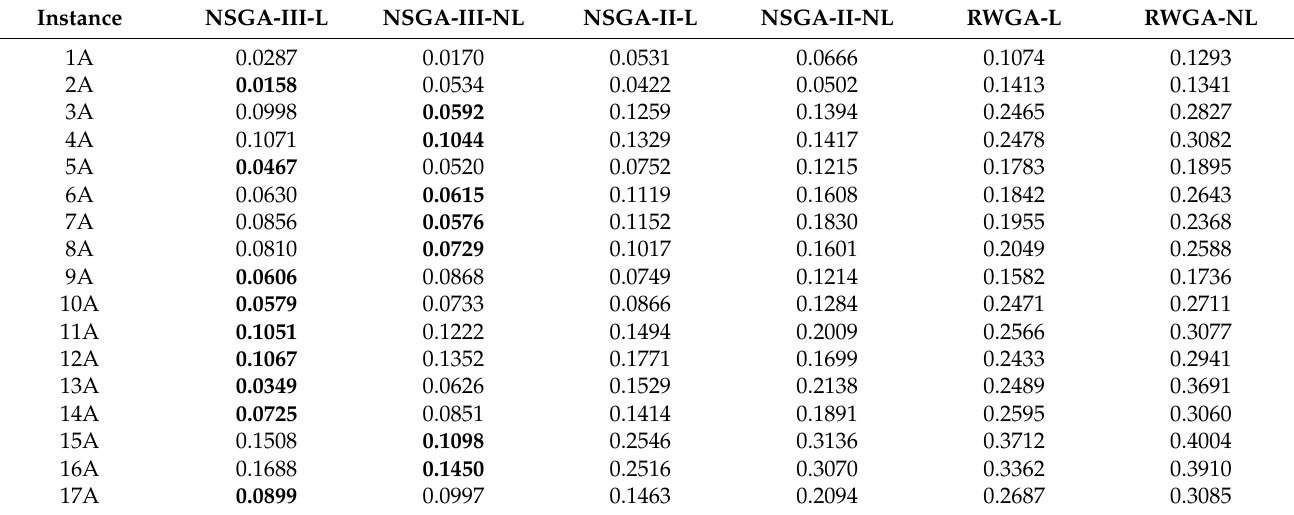
Table 9. Experimental results of